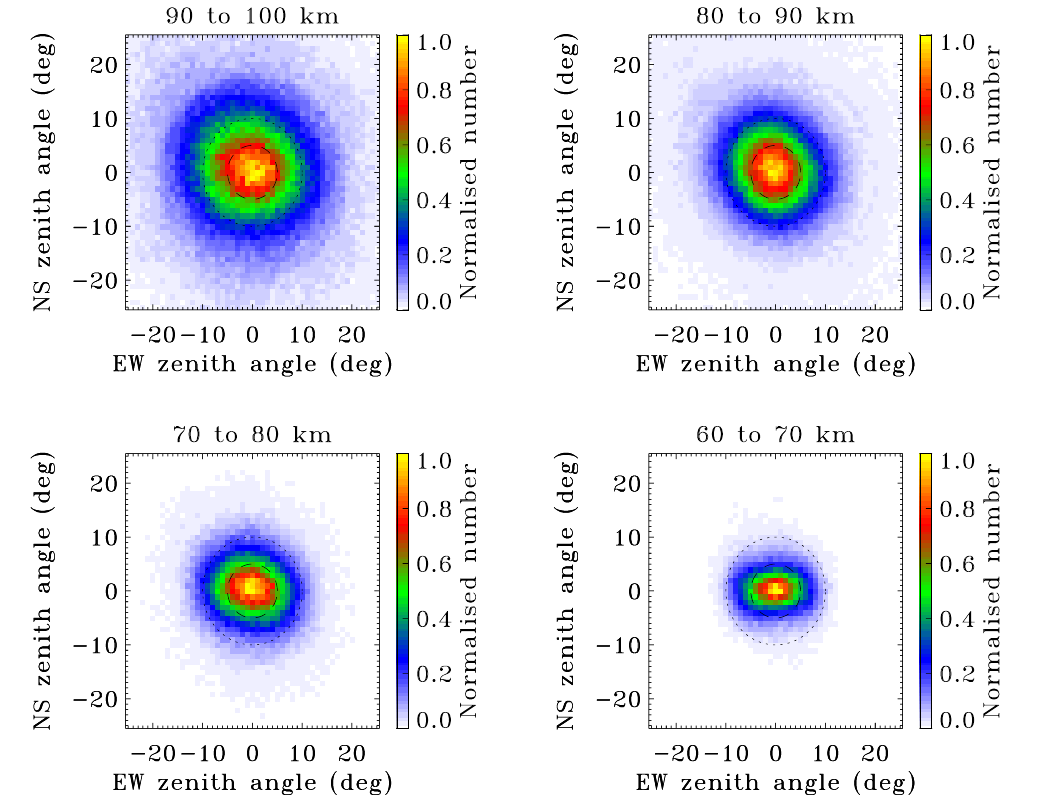
Fig. 4. Histograms of effective scattering positions for 90–100km (top left), 80–90km (top right), 70–80km (bottom left) and 60–70km (bottom right) from 19 January 2000 to 3 Februaray 2000. The dashed and dotted line indicate the transmit beam half-power half-width and twice the half-power half-width, respectively.